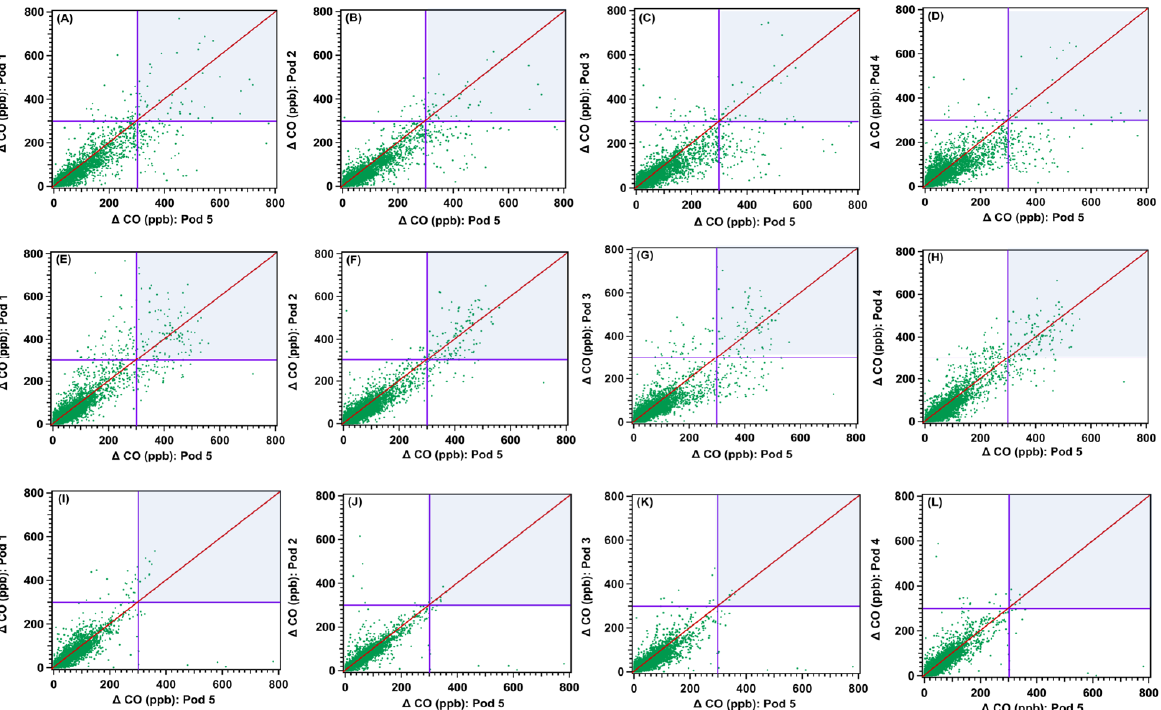
Figure 6. Scatter plots comparing the CO levels of the co-located pod against other pods in the network. ( A – D ) illustrate the scatter plots for the Fall 2020 time period, ( E – H ) illustrates the scatter plots for the Winter 2021 period, and ( I – L ) illustrates the scatter plots for the Summer 2021 period. The top right quadrant highlighted in blue denotes the CO enhancement quadrant.